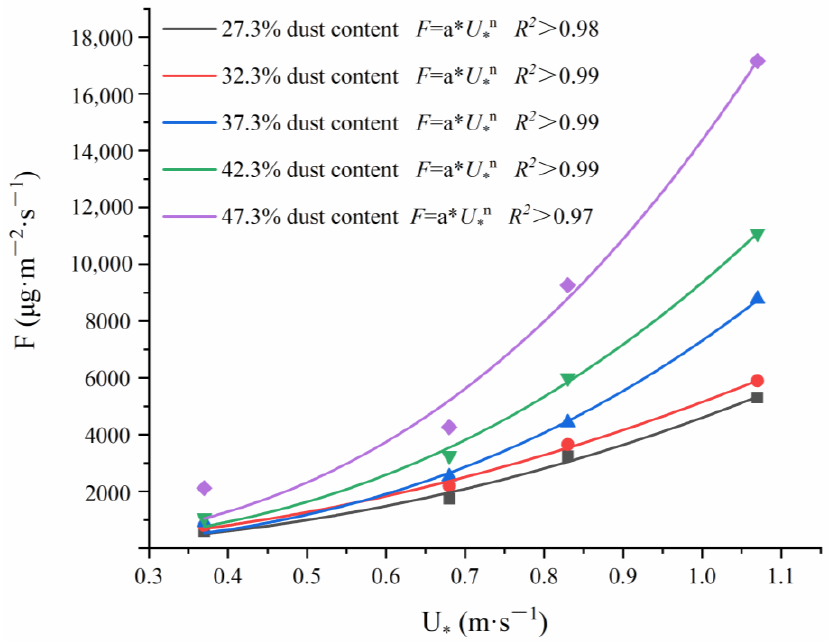
Figure 4. Variation of F with U ∗ under different Gobi dust content conditions. Table 1. Regression coefficients in Equation (3).